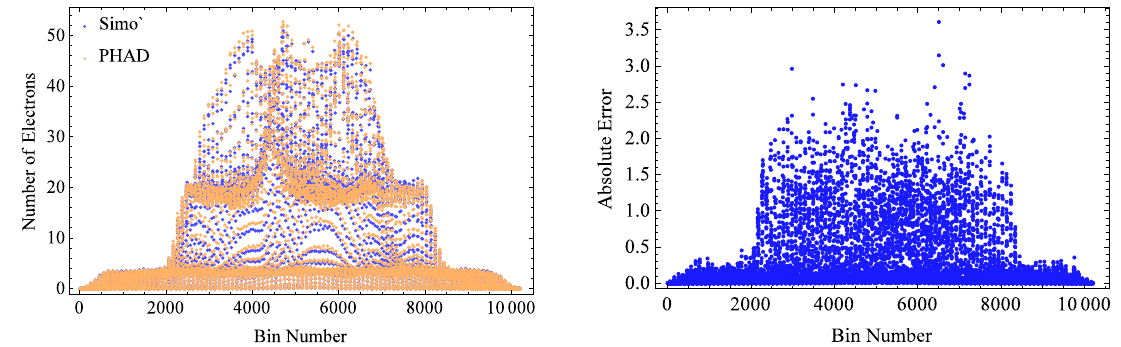
FIG. 9. The resulted transverse density of six electron beamlets within a halo of electrons simulated by the standalone Simò integrator and PHAD (left). The difference between these resulted densities (right) shows that the accuracy of PHAD is comparable to that of the standalone Simò